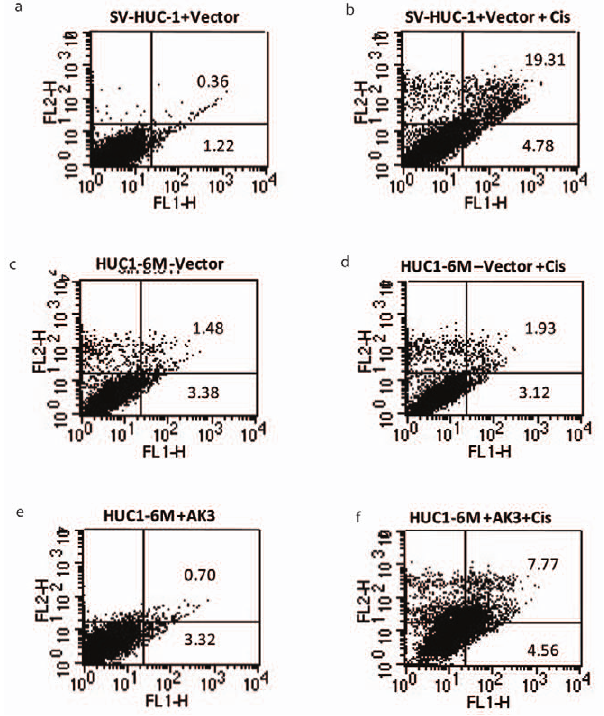
Figure 5. Activation of Apoptosis in the Presence of AK3 and Cisplatin. Apoptosis was measured in the SV-HUC-1 and HUC1-6M cells using annexin/PI staining. The cells were transfected with or without AK3 expression plasmid and treated with or without cisplatin for 48 h as indicated.